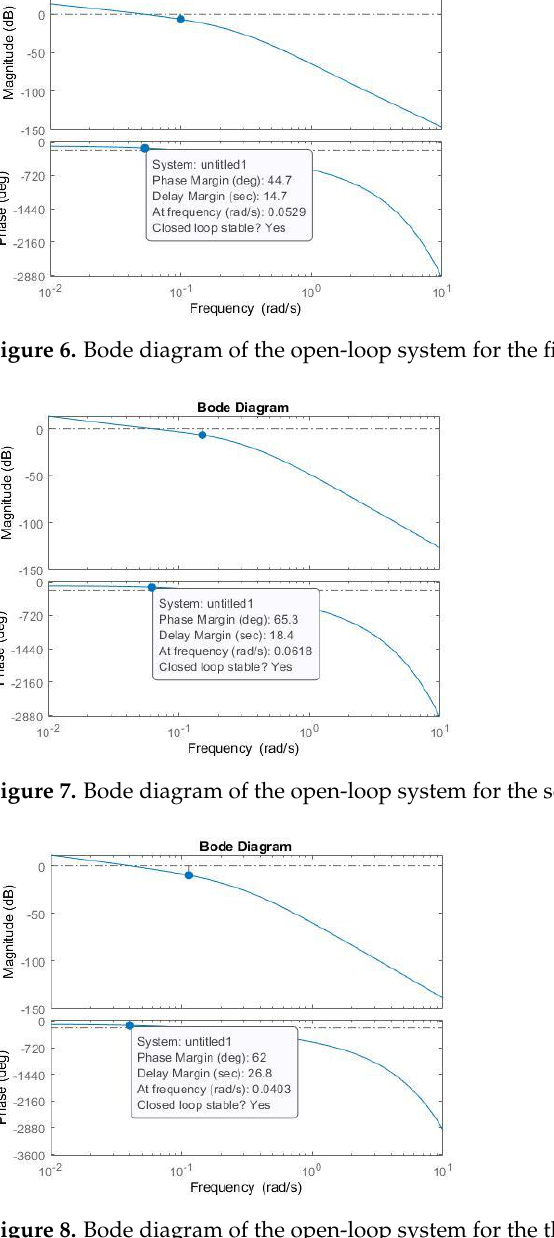
Figure 9. Step responses of the closed-loop system for the three designed FO-PI controllers. The third experiment is the design of the FO-PID controller using Equations (4) – (8). The imposed performance measures are the same as in the previous experiments. The resulting controller parameters are highlighted in Table 3. Table 3. The imposed performances and the resulting FO-PID controller parameters.